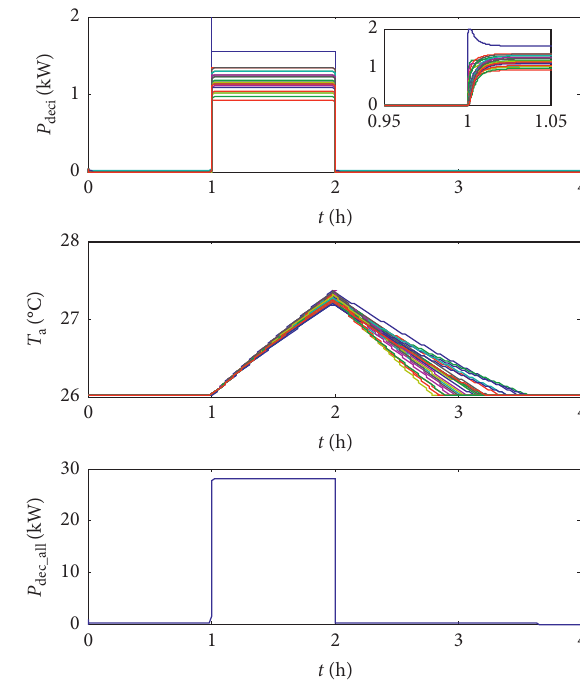
Figure 10: Simulation results of method 3. Table 3: Comparison of performance from methods